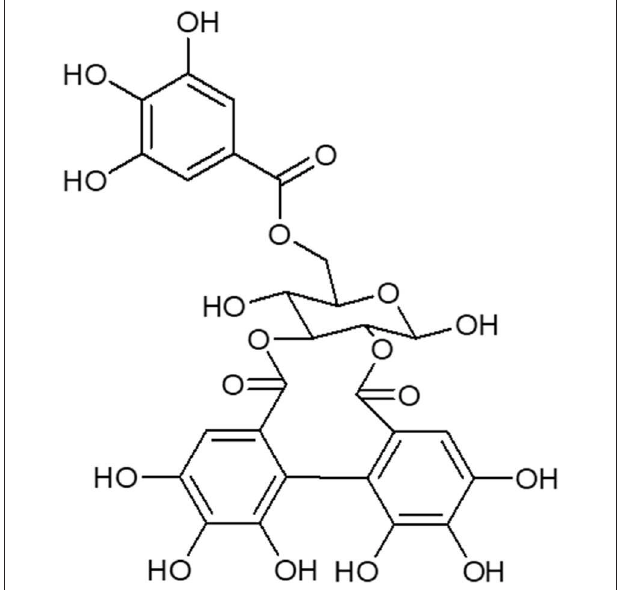
FIGURE 1 | Structure of galloyl-HHDP-glucose isolated from the hydroalcoholic extract of Punica granatum L .